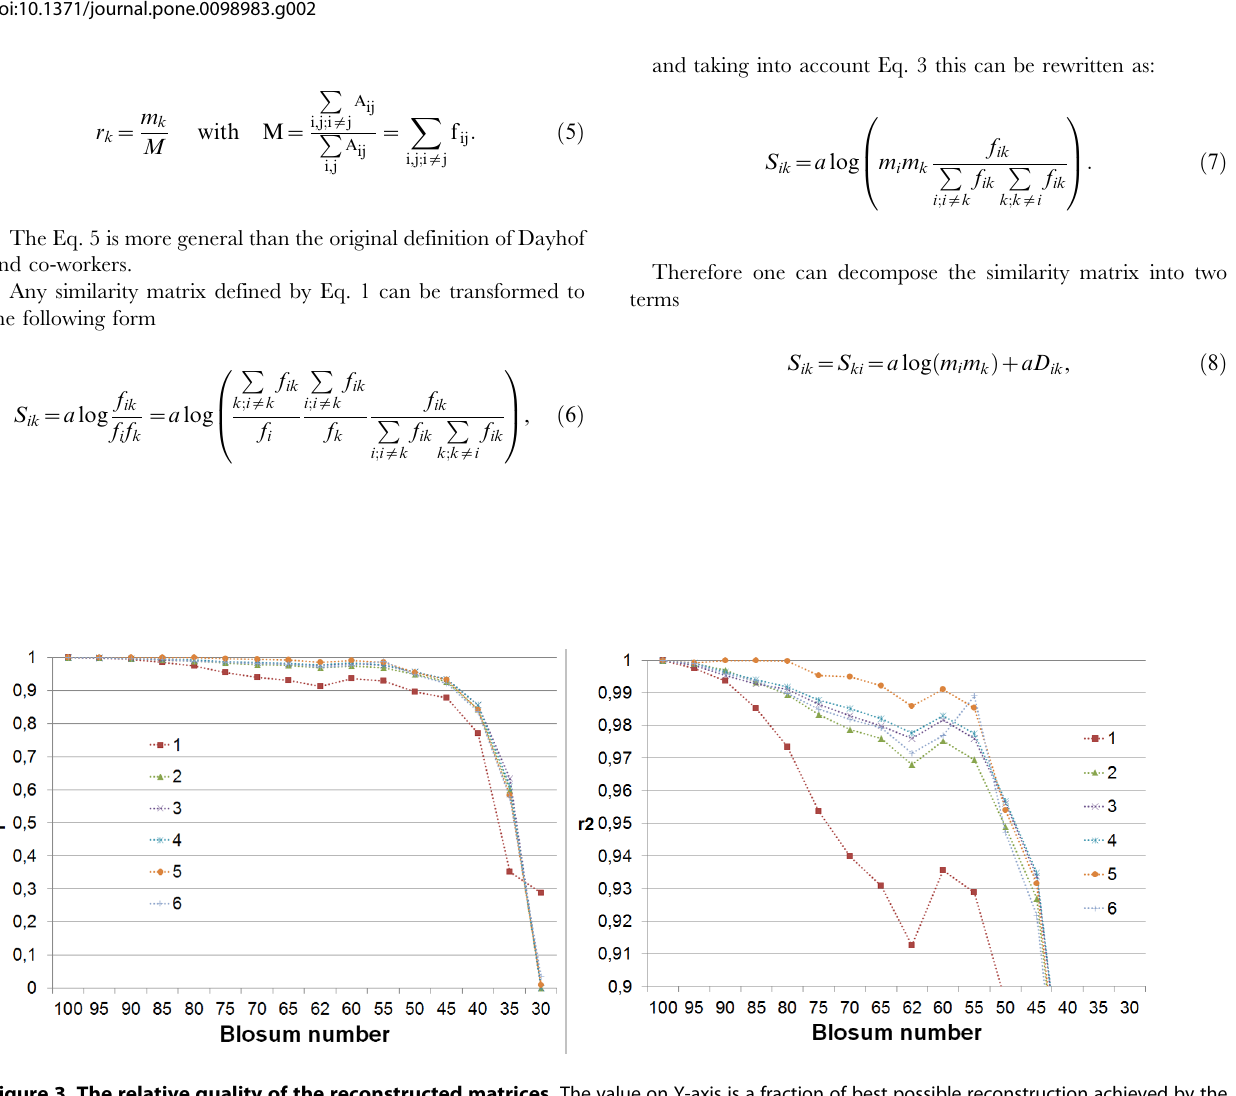
Figure 3. The relative quality of the reconstructed matrices. The value on Y-axis is a fraction of best possible reconstruction achieved by the model. It is estimated as a fraction of r 2 achieved in reconstruction with eigenvectors derived from B 100 and r 2 obtained in reconstruction with its own eigenvectors. The left panel displays entire range of Y, the right panel is a close-up for Y larger than 0.9.